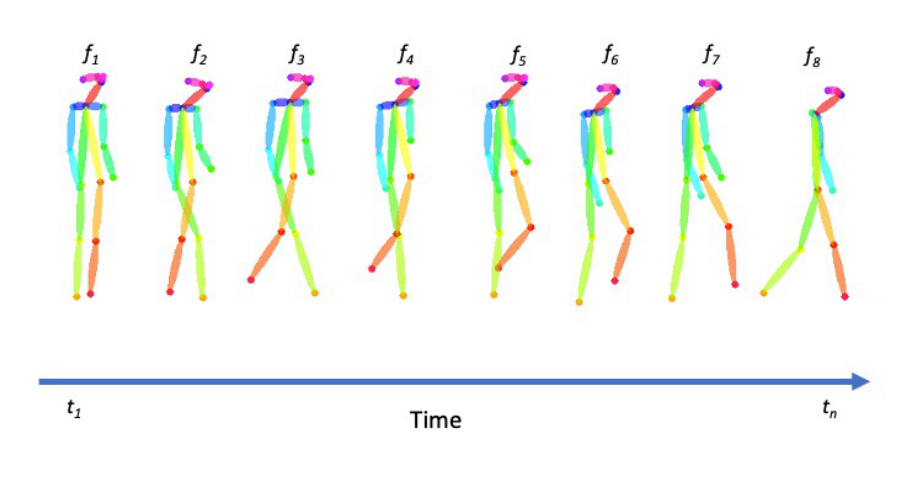
Figure 5. Visualization of a stride using the extracted body keypoints from a video using